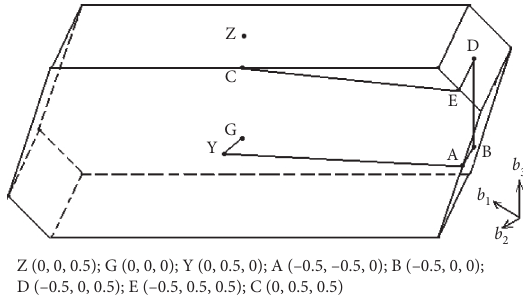
Figure 3: The reduced Brillouin zone and irreducible high sym- metry points of sandwiched Ca 2 Co 2 O 5 crystalline